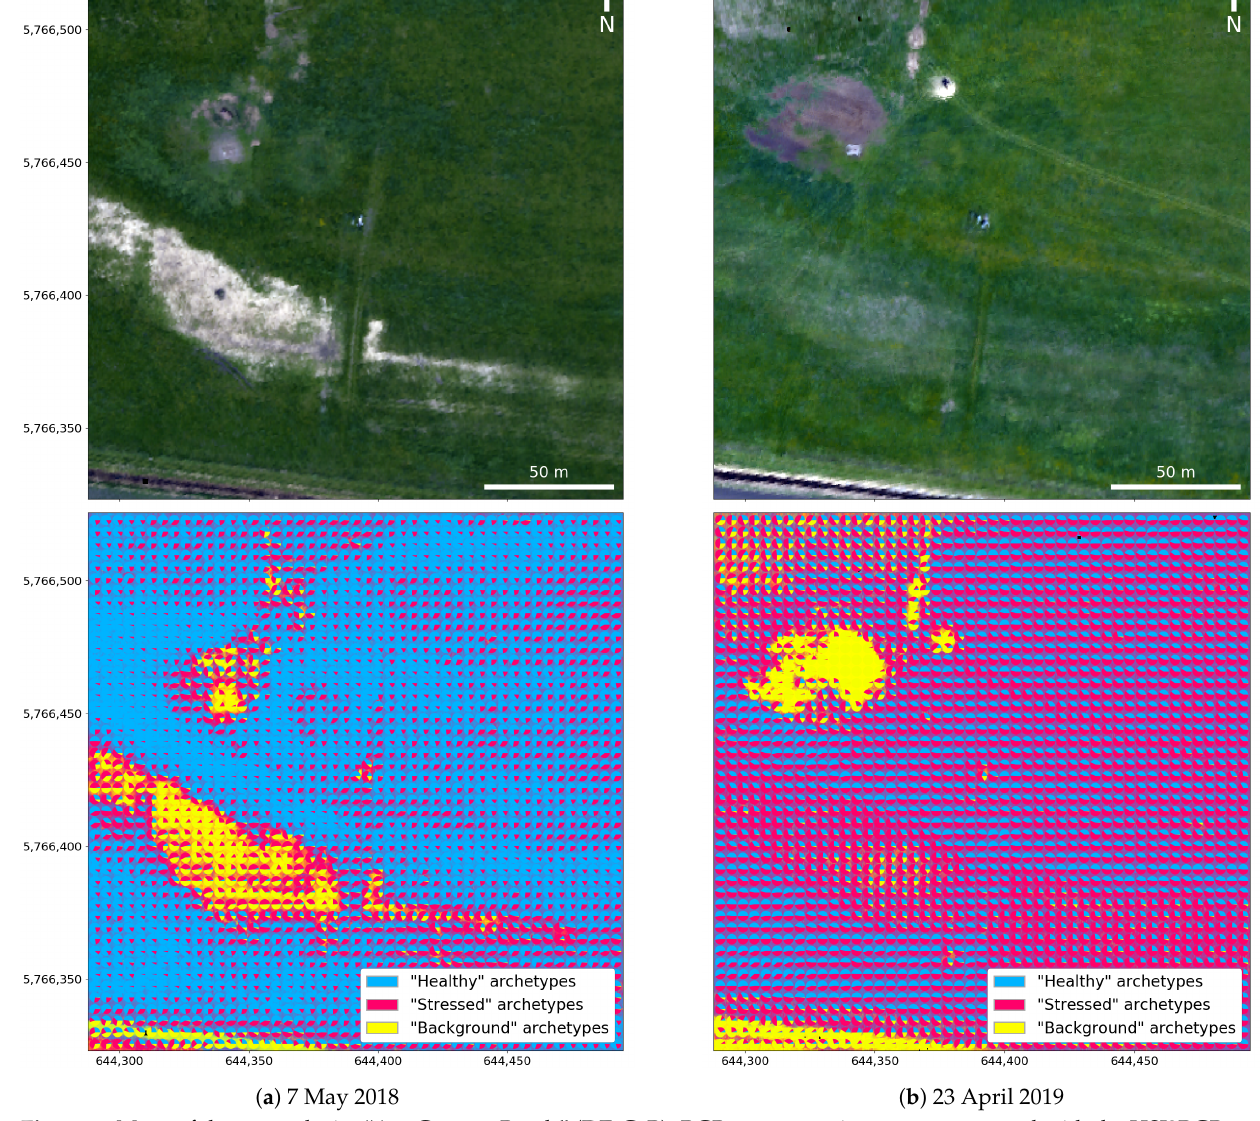
Figure 5. Maps of the research site “Am Grossen Bruch” (DE-GsB). RGB representations were computed with the HSI2RGB python module [109]. The double layer maps show the distribution of archetype classes. Archetype coefficient values per pixel always add up to one due to the convexity constraint of simplex volume maximisation (CRS: